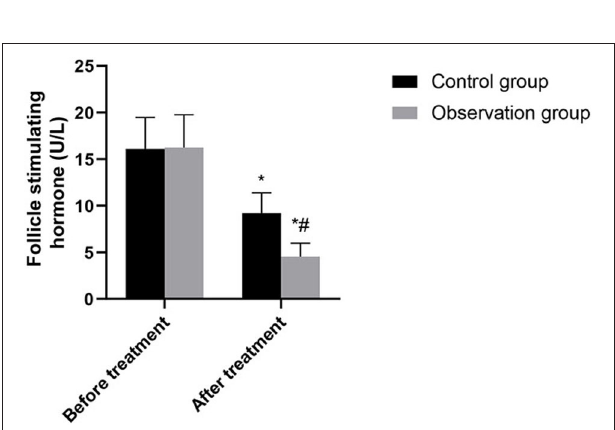
FIGURE 2 | Comparison of follicle-stimulating hormone between the two groups. Compared with before treatment, * P < 0.05. Compared with control group, # P <